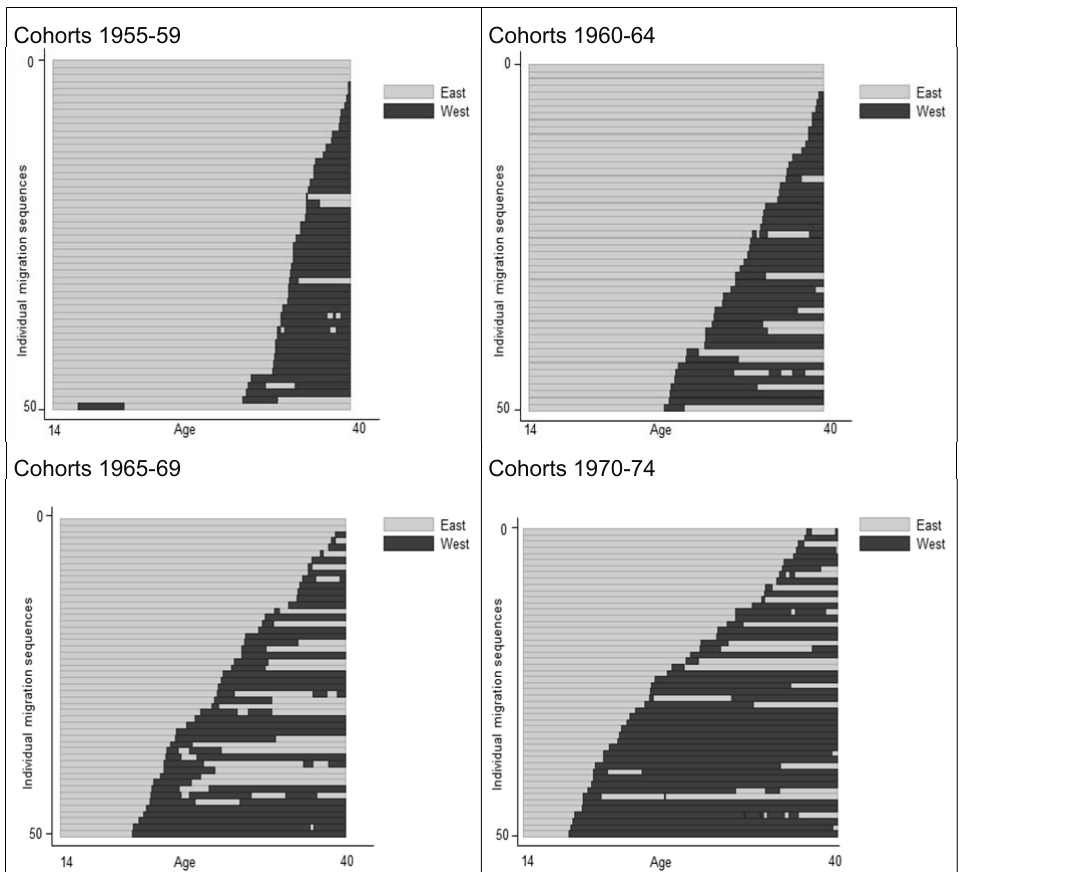
Figure 3 : Migration biographies of selected East-West German migrants, sequence index (plot of 50 randomly selected persons per